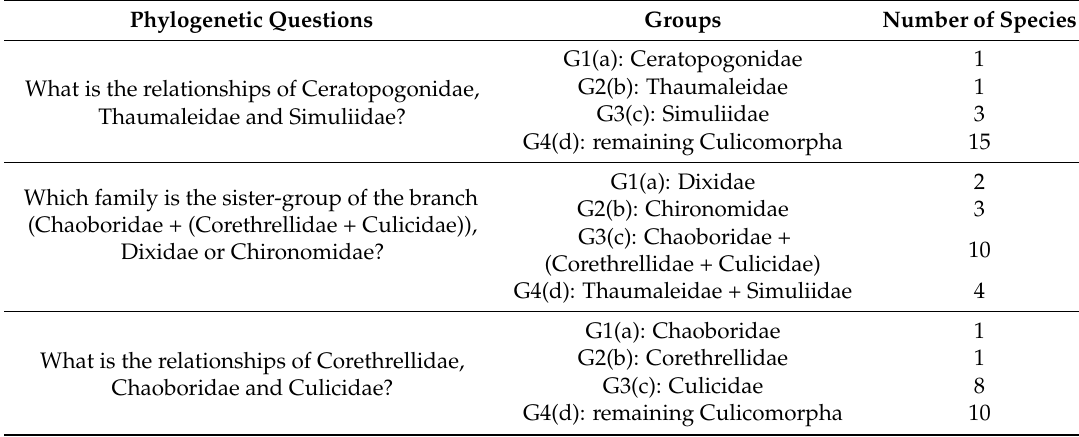
3/747/s1. Table S1: Collection information of specimens. Table S2: Primers used in this study. Table S3: Organization of four Culicomorpha mt genomes. Table S4: Nucleotide composition of four Culicomorpha mt genomes. Table S5: Codon usage of four Culicomorpha mt genomes. Table S6: The best partitioning scheme selected by PartitionFinder for different datasets. Figure S1: BI and ML trees based on PCGRNA, PCG12RNA, PCG and PCG12. Figure S2: BI and ML trees based on PCGRNA, PCG12RNA, PCG and PCG12 with removing the